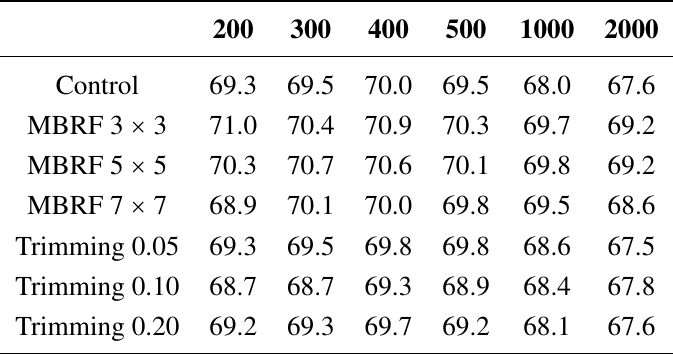
Table 2. Overall accuracy values ( n = 657 ) for the Eurasian region according to the automated sample selection methods.